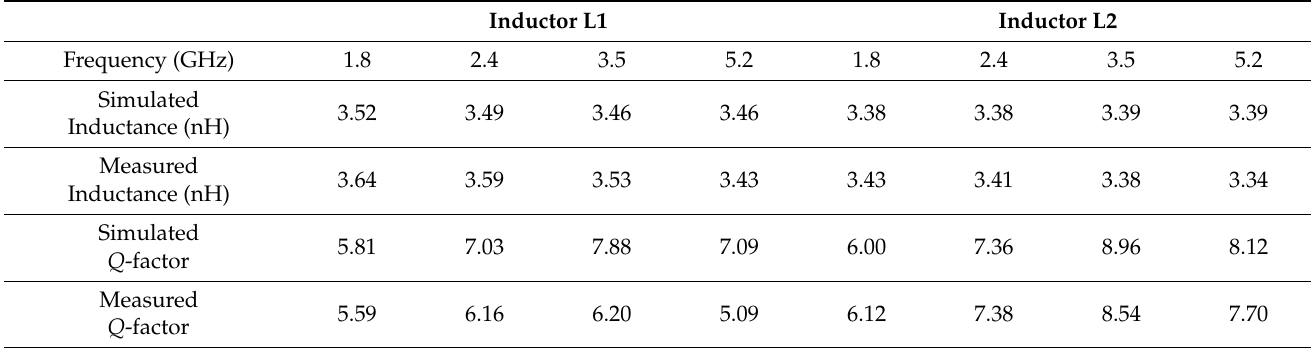
Table 3. A comparison of the performances of inductors L1 and L2 at typical